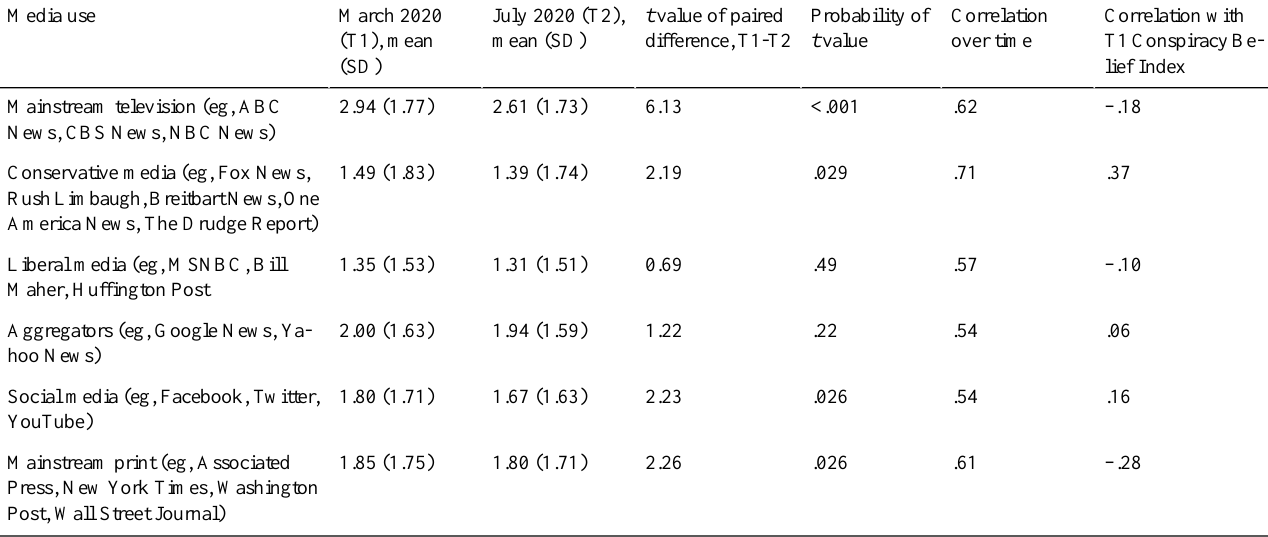
Table 1. Use of six media (with examples of each) as sources of information in both March (T1) and July (T2) of 2020 and relations with political ideology